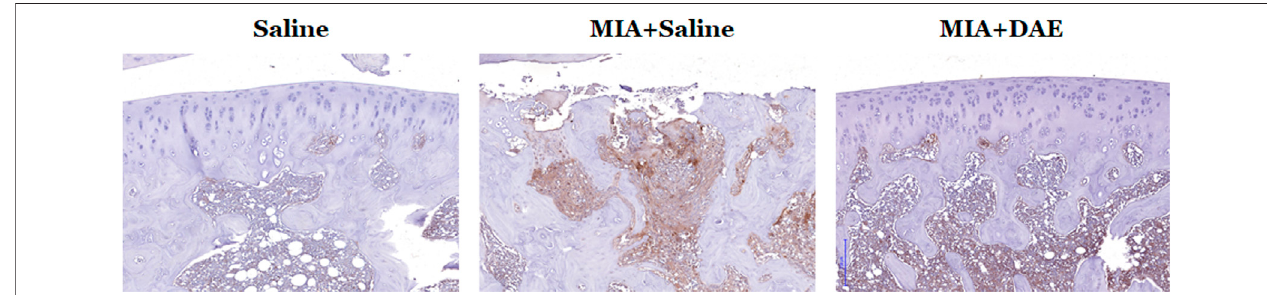
FIGURE6| Effectsof Dipsacusasperoides ethanolicextract(DAE)ontheexpressionofMMP9inkneejointlesionsofMIA-inducedOArats.Representativeimages ofimmunohistochemicalstainingofMMP9expressioninkneejointtissue.Scalebars (cid:2) 200 μ m.Saline,ratsgivensaline(vehicle);MIA+Saline,ratsinjectedwithMIAand given saline; MIA + DAE, rats injected with MIA and given